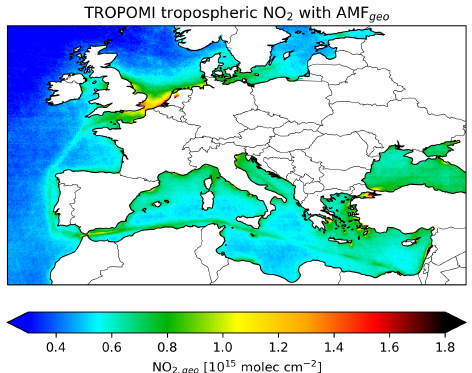
Figure B1. Mean of NO 2 columns calculated with geometrical AMF for summer 2019 (May–September); land areas have been whitened for clarity.